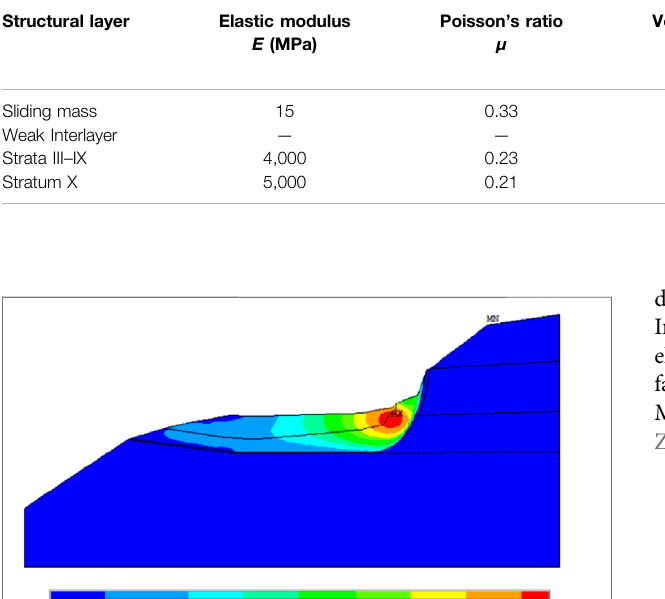
TABLE 3 | Mechanical parameters of rock and soil.